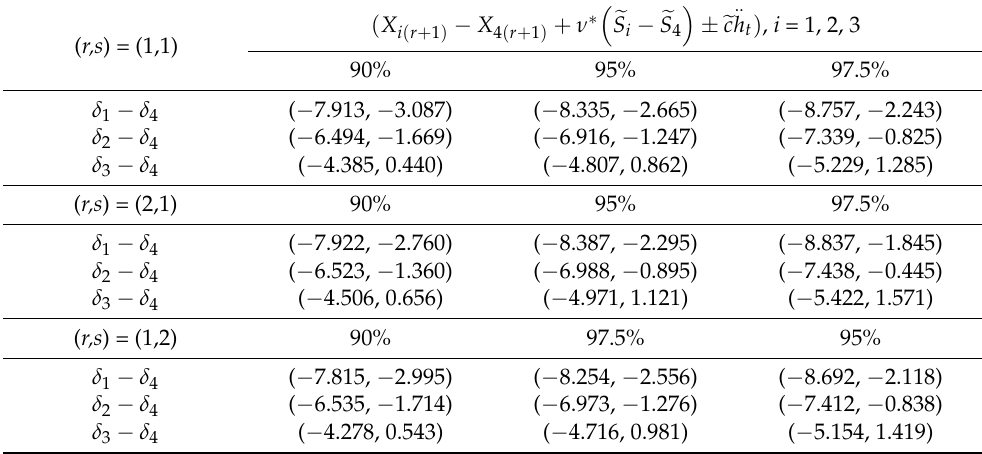
Table 3. The two-sided confidence intervals for three drugs compared with the control drug (drug